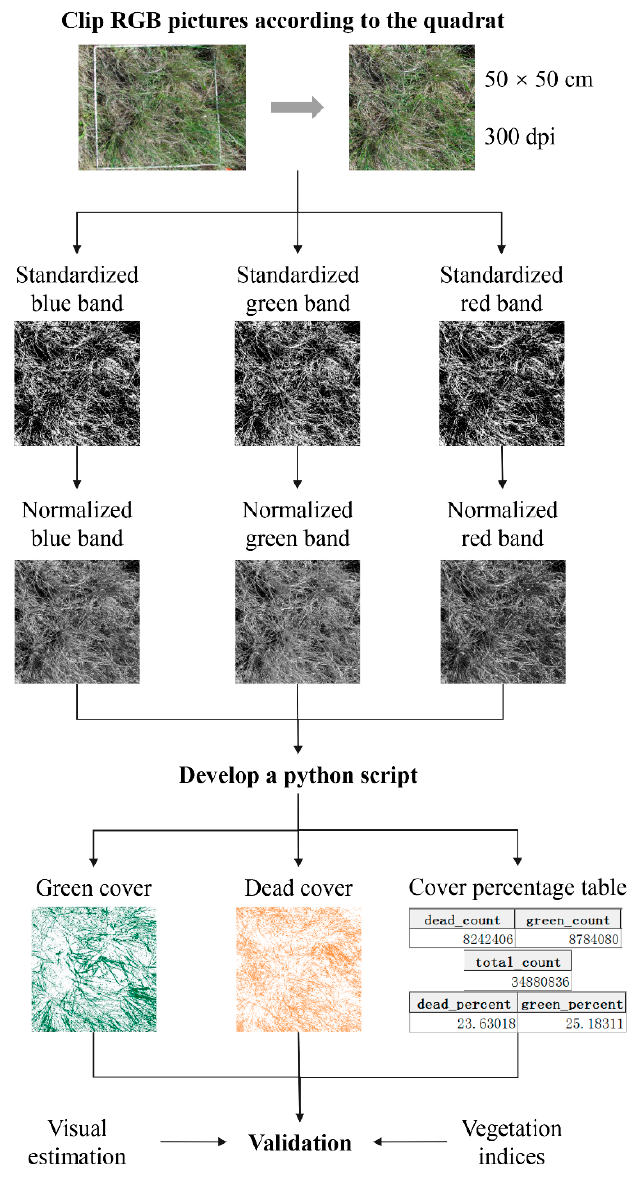
Figure 2. Flowchart of the methodology for this study.